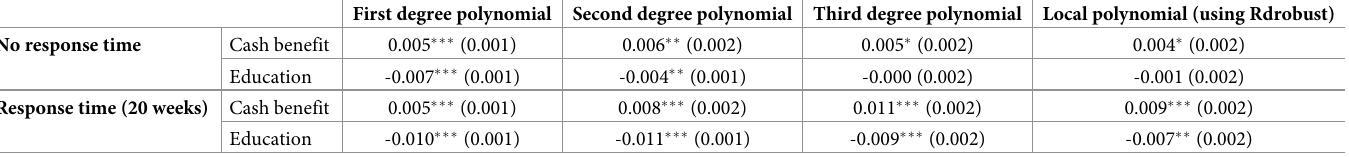
Table 3. RD estimates for young adults with low educational